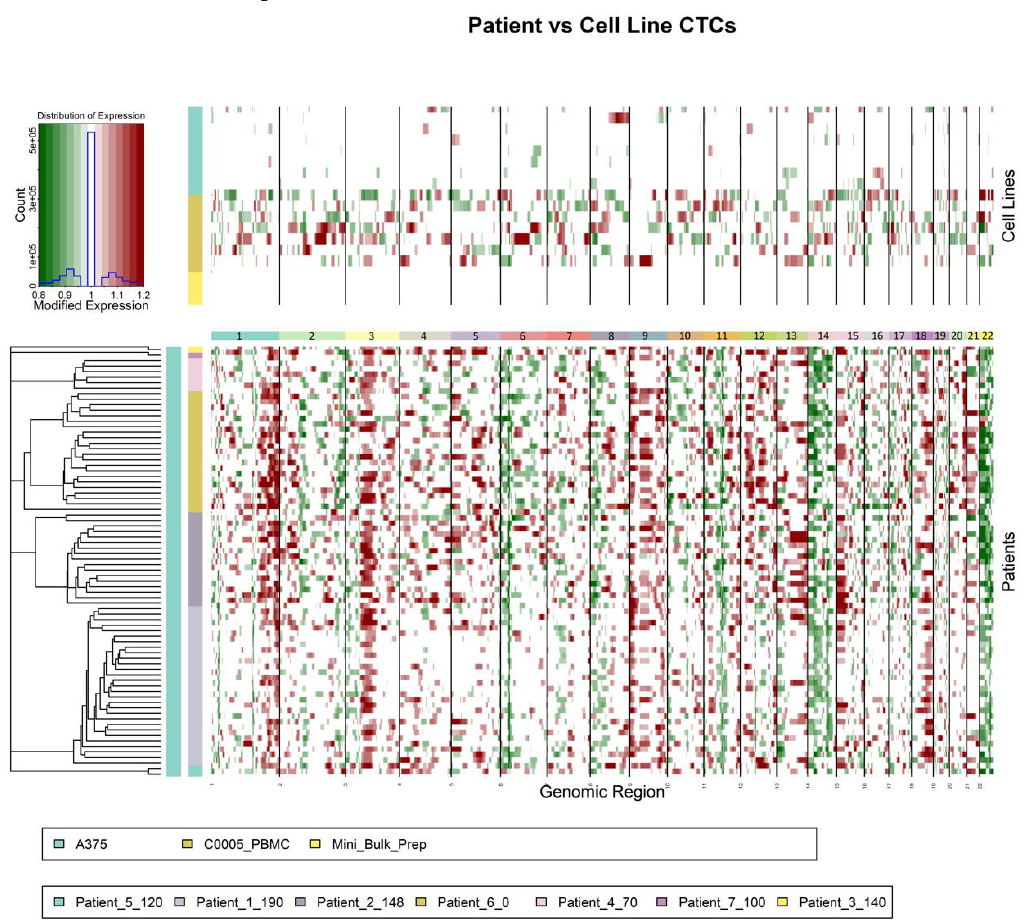
Figure 8. Copy Number Variation Analysis Highlights Differences Between CTCs and PBMCs: Chromosomal sequencing organized by chromosome number for patient CTCs (bottom), A375s (top), and PBMCs (top).